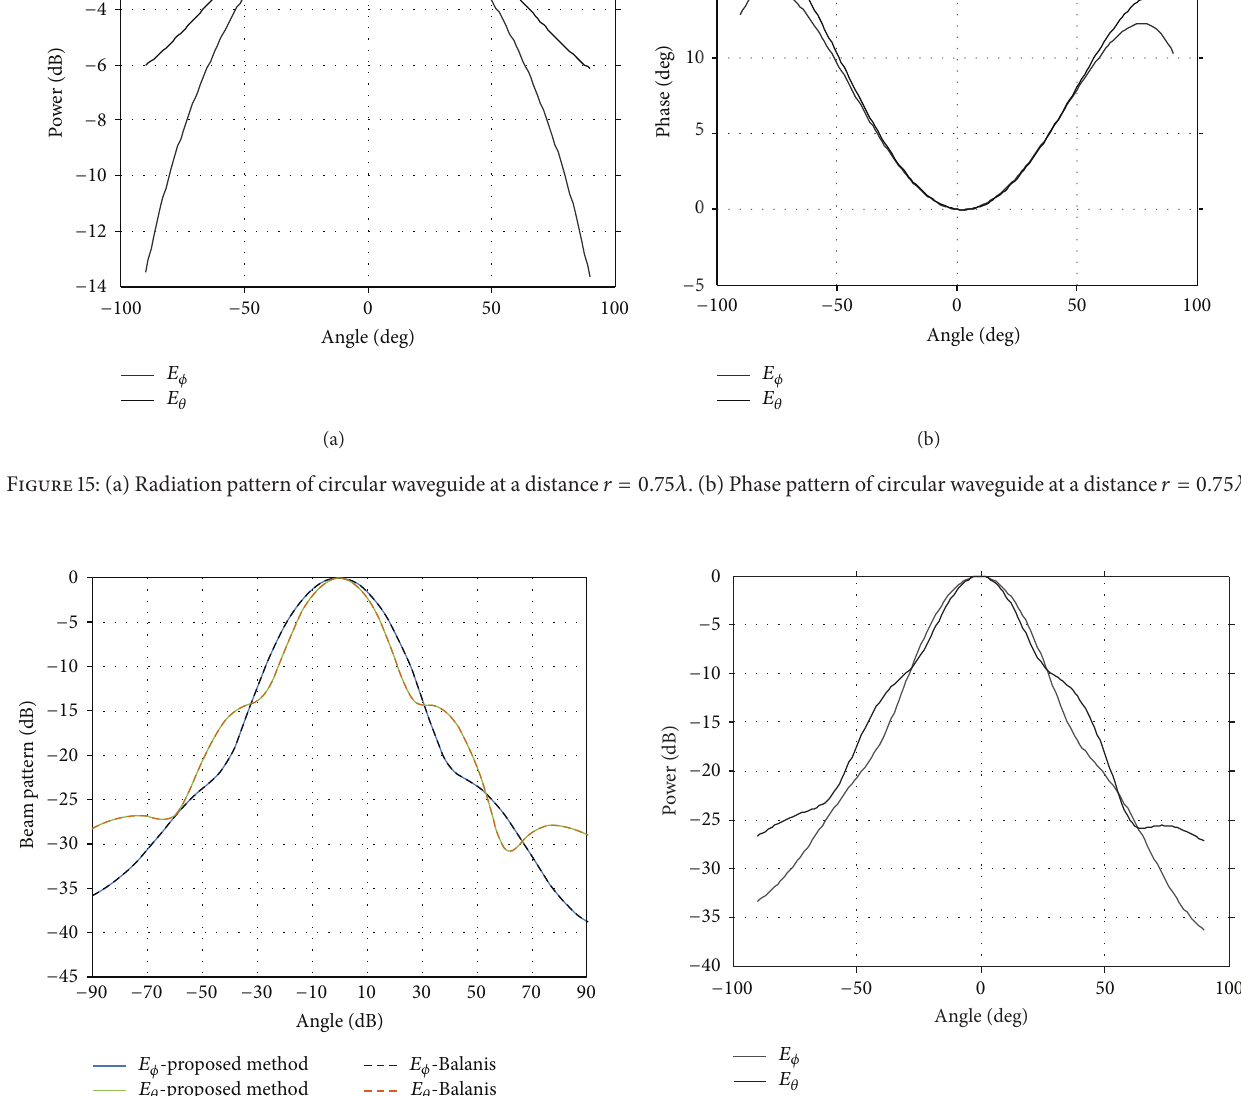
Figure16:Comparisonoffarfieldradiationpatternsofconicalhorn antenna obtained from [𝑥] and proposed near field method.